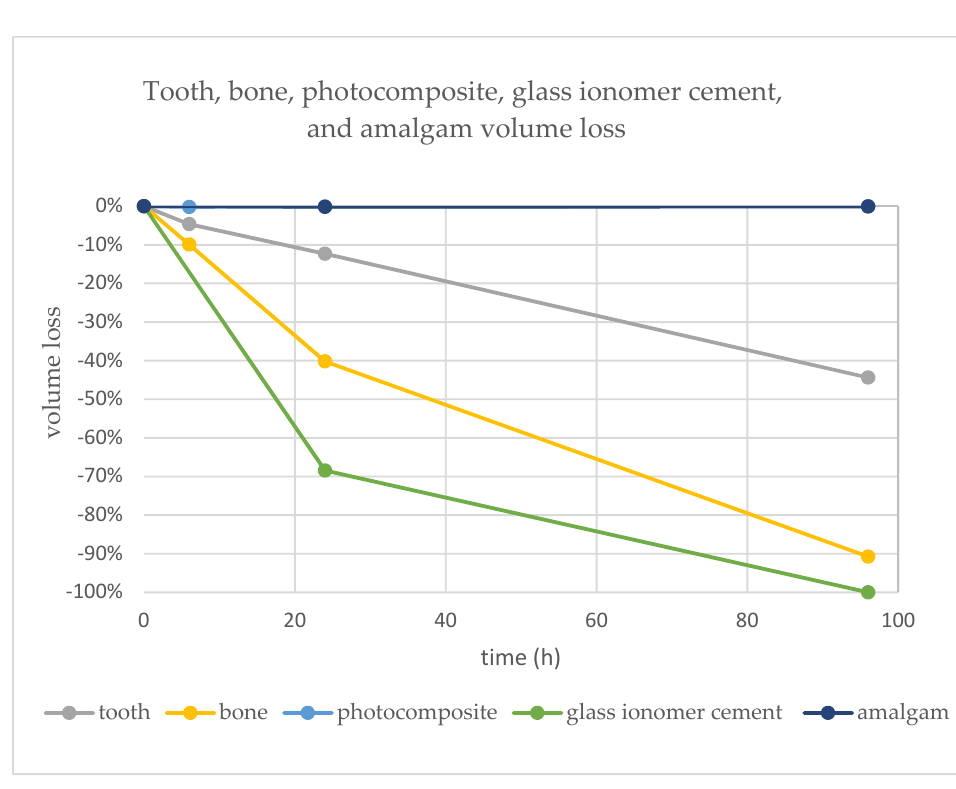
Figure 9. Graph representing volume loss over time in tooth, bone, composite, glass ionomer cement, and amalgam. The representation of composite (photocomposite) resin is hidden behind amalgam. Table 1. Volume loss of dental materials and bone after exposure to 75% sulfuric acid.